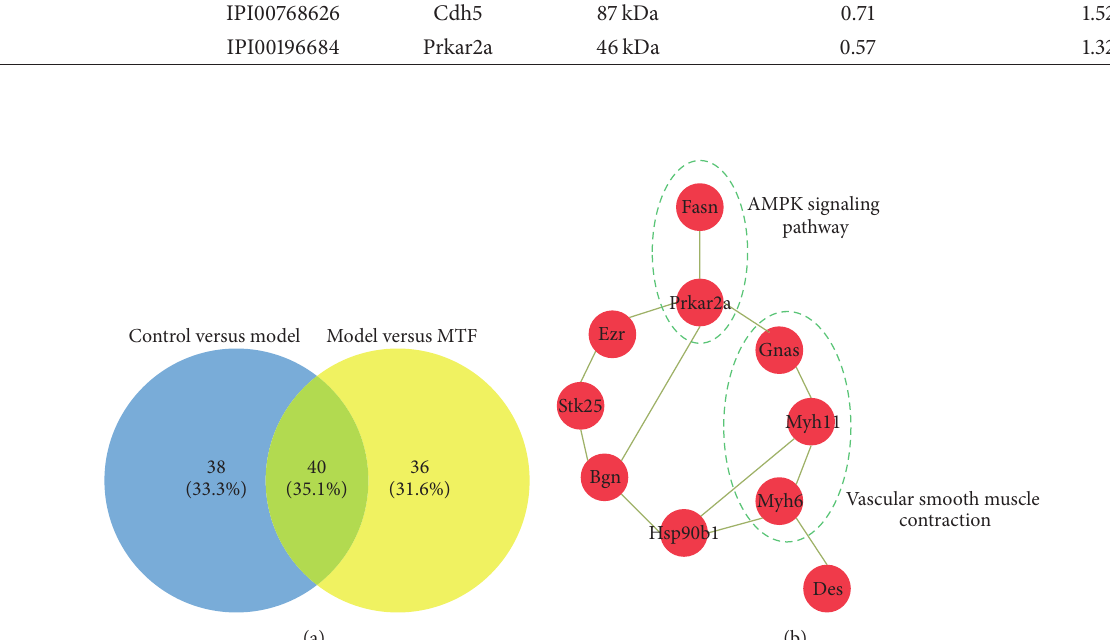
Figure3:VennyplotofDPsbetweeneachgroupandthePPInetworkoftheDPsnormalizedbyMTFtreatment.(a)VennyplotofDPsbetween each group (control versus model and model versus MTF); (b) PPI network of the DPs normalized by MTF treatment. Line: interaction; red node: